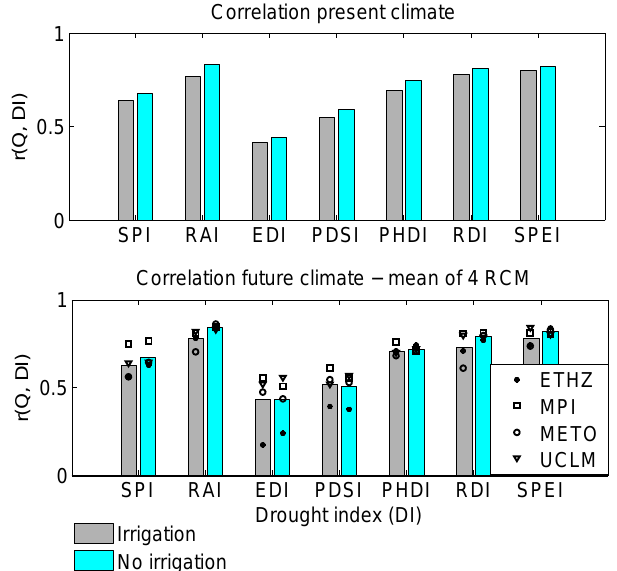
Figure 5. Correlation coefficient r between the drought indices and discharge. The irrigation scenarios are PIRR in the present climate and FUTIRR in the future climate. In the future climate (bottom panel), the plotted bars are the average of the outputs of the four regional climate models. See Table 2 for information about the four regional climate